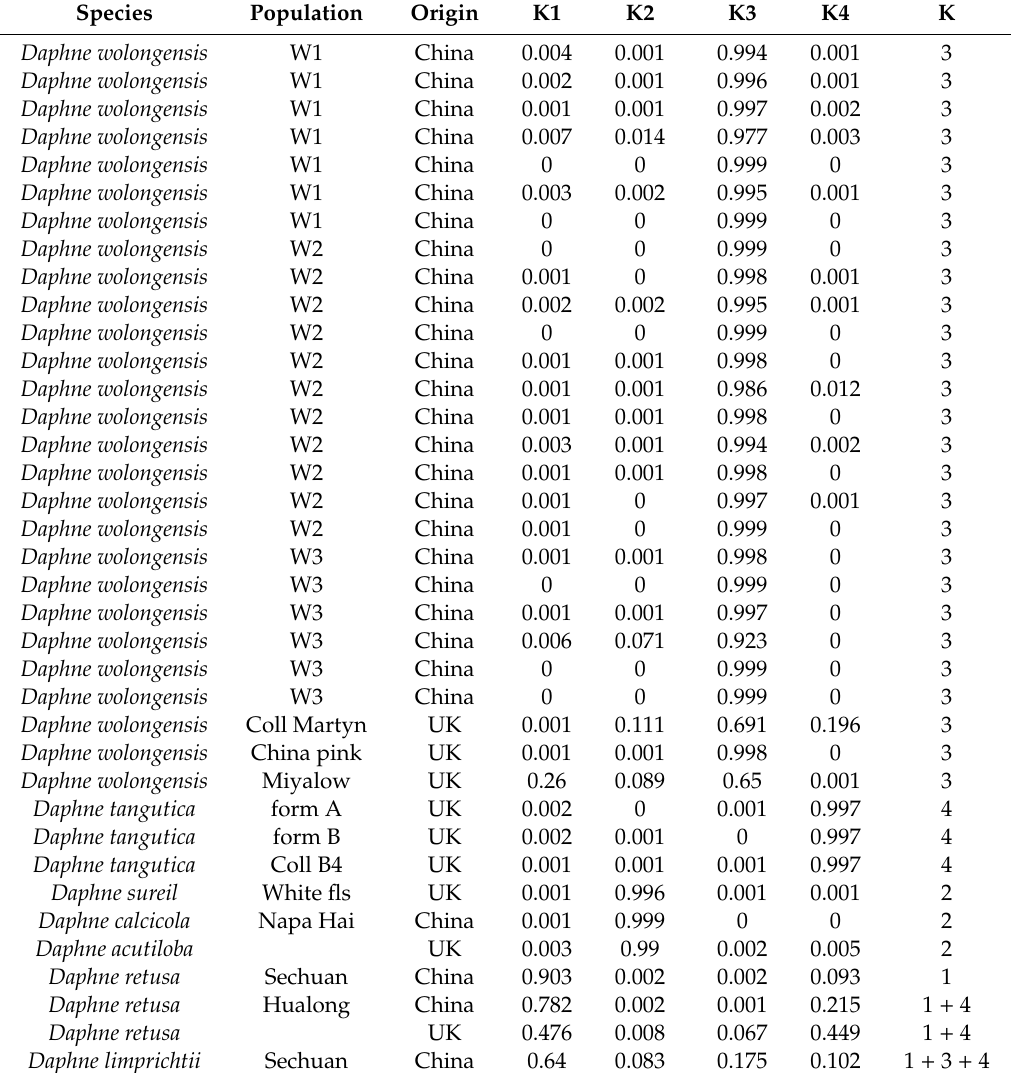
Figure 4. Cluster analysis of Daphne spp. based on a Bayesian approach. Each genotype is represented by a bar divided into K colors, where K is the number of clusters assumed in the analysis: K1—red color; K2—green color; K3—blue color; K4—yellow color. The y -axis represents posterior probability of individual assignment to genetic populations K1—K4. Table 4. Proportions of membership of each analyzed individual in each of the four clusters